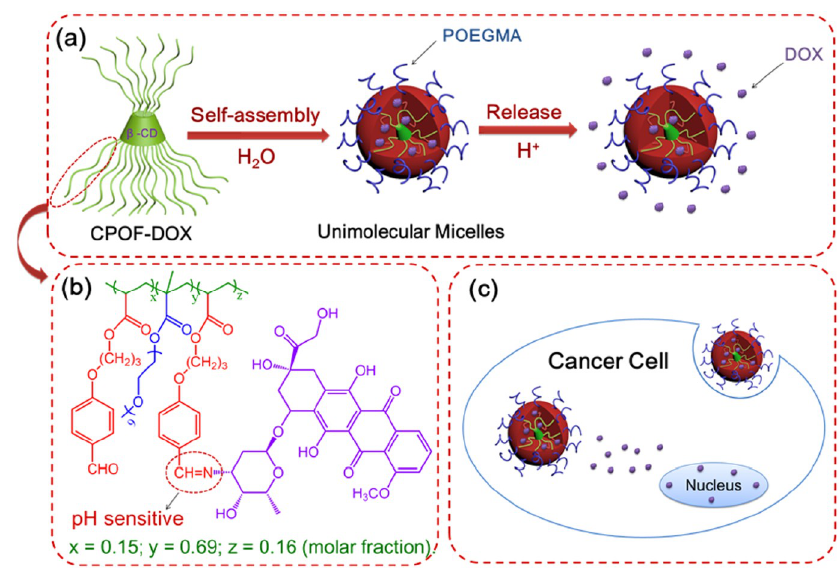
Figure 8. ( a ) Schematic representation of β -cyclodextrin-based copolymers, forming unimolecular micelles in aqueous solution. In acidic media, they release doxorubicin (purple dots); ( b ) Chemical structure of each arm of the multi-arm polymer. Doxorubicin is connected to the benzaldehyde-bearing monomer via a Shiff-base linkage; and ( c ) unimolecular micelles are internalized by HeLa cells, and after being released, doxorubicin accumulates in the nuclei. Reproduced with permission from American Chemical Society. Reproduced with permission from reference [81], American Chemical Society, 2017.